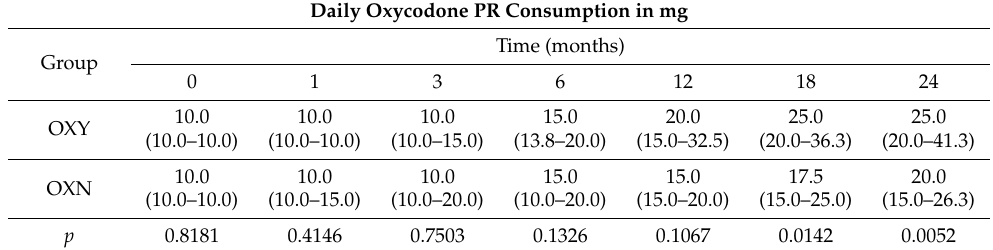
Table 2. Comparison of drug dosage between two groups across time, at different timepoints (baseline, 1, 3, 6, 12, 18 and 24 months). Values are expressed as median [IQR 25–75]. Group OXY, oxycodone; Group OXN, oxycodone + naloxone. Daily Oxycodone PR Consumption in mg Group